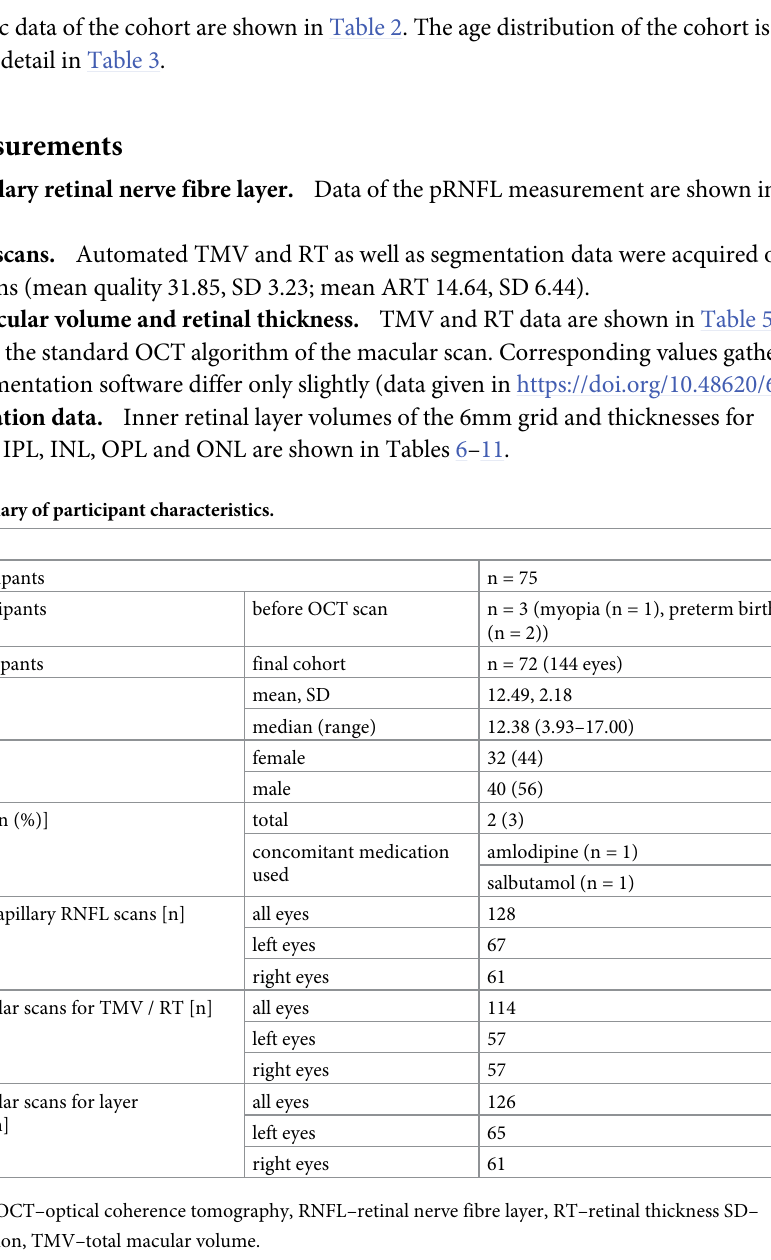
Abbreviations: OCT–optical coherence tomography, RNFL–retinal nerve fibre layer, RT–retinal thickness SD– standard deviation, TMV–total macular